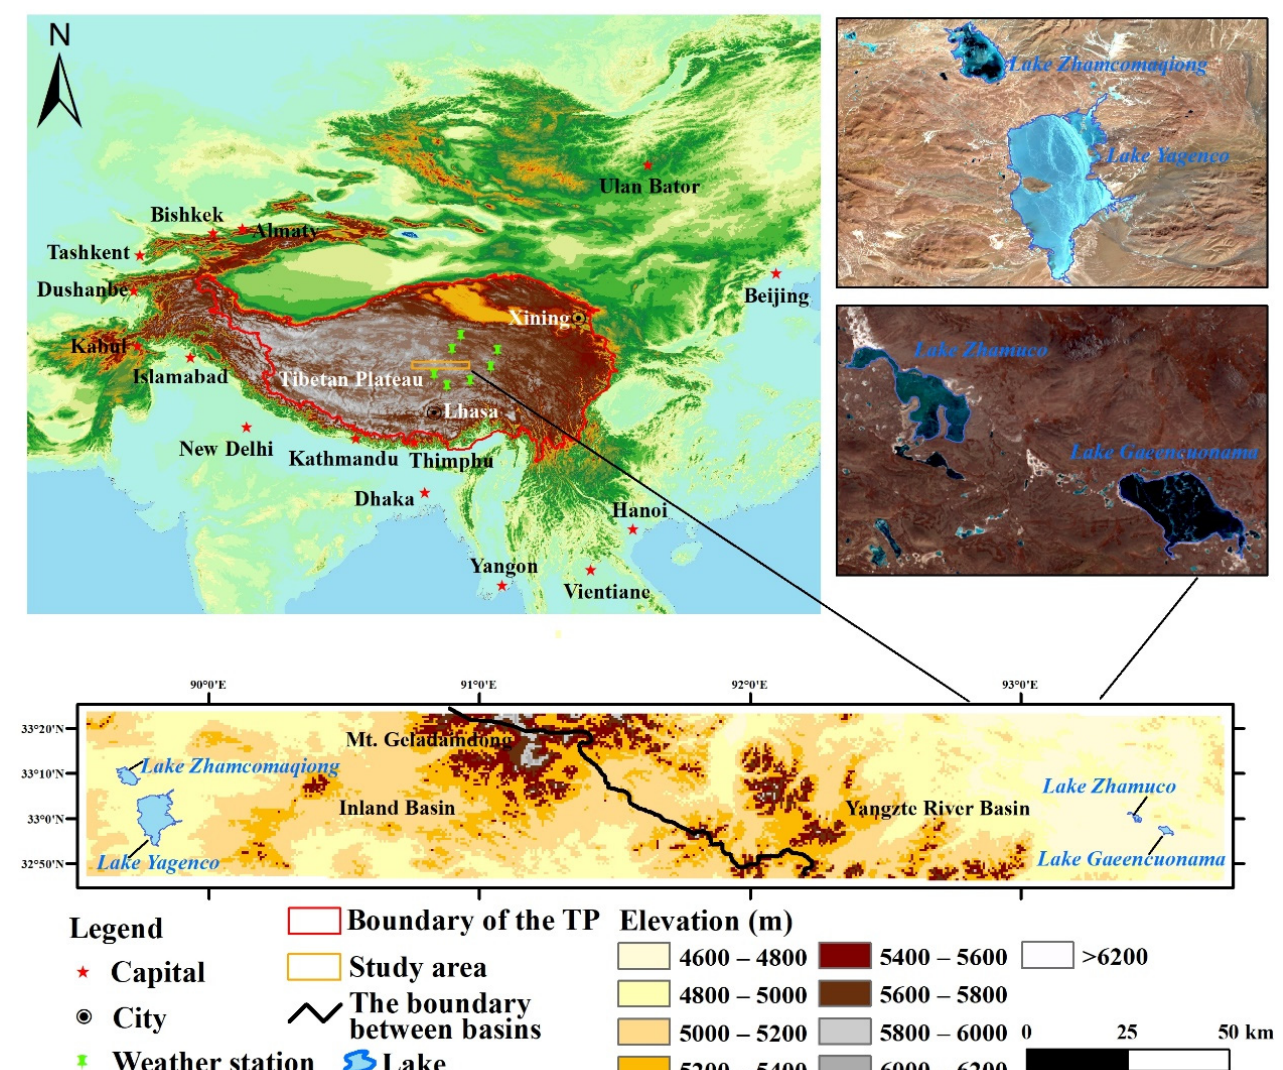
Figure 1. Map of the study area showing the spatial distribution of the lakes and the surrounding topography of the central Tibetan Plateau.